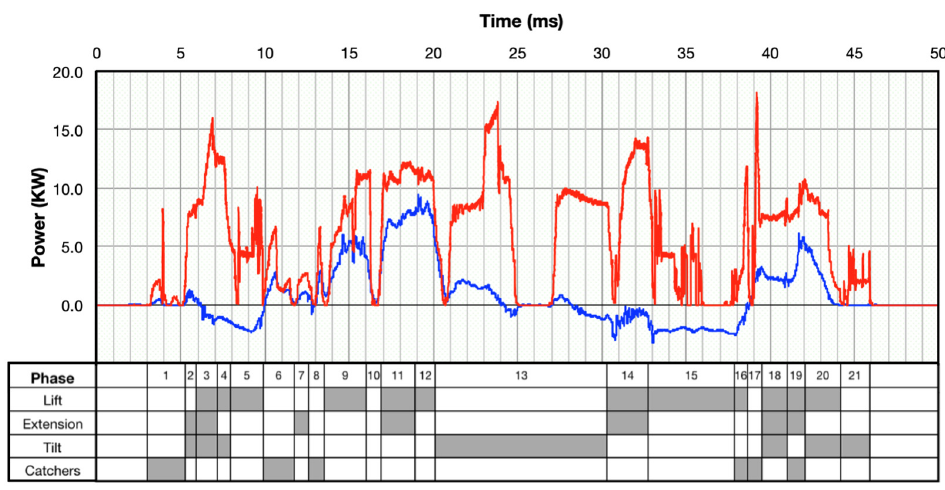
Figure 11. Cycle phases and total power demand.